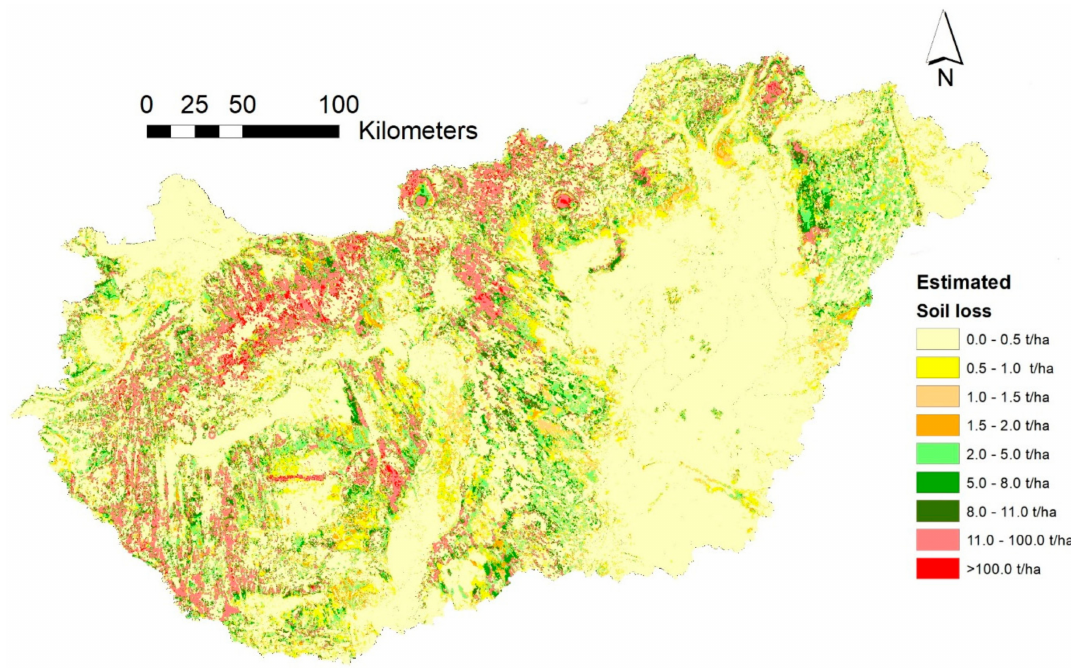
Figure 6. Estimated soil loss for 2018 LULC by the Pan-European Soil Erosion Risk Assessment (PESERA) model.